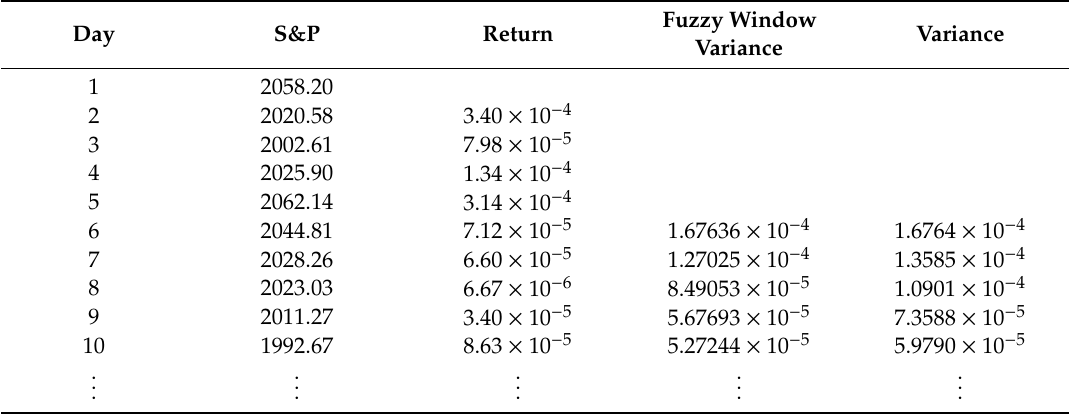
Table 3. Fuzzy window variance and variance of the FLR-FSWGARCH model.